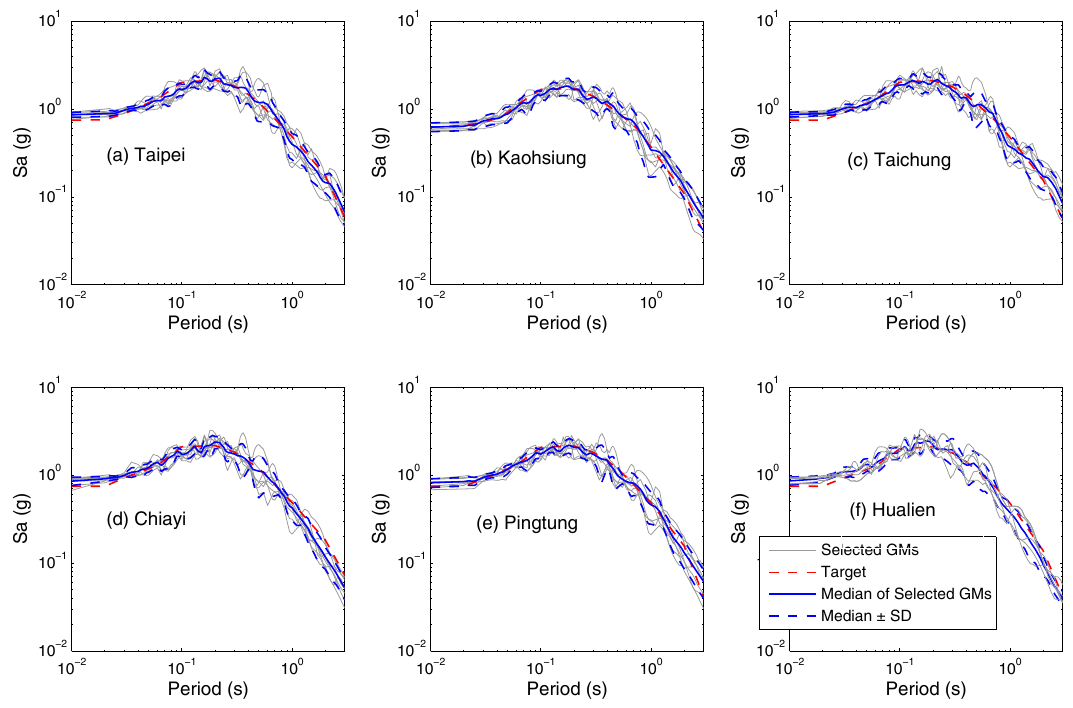
Figure 7. The target spectrum, individual and average response spectrum of selected records for six major cities in Taiwan.